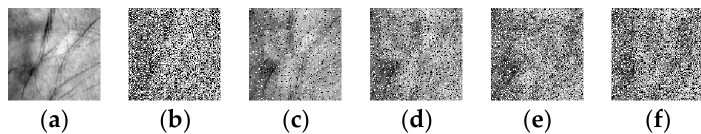
Figure 10. Recognition rate versus the training sample number.